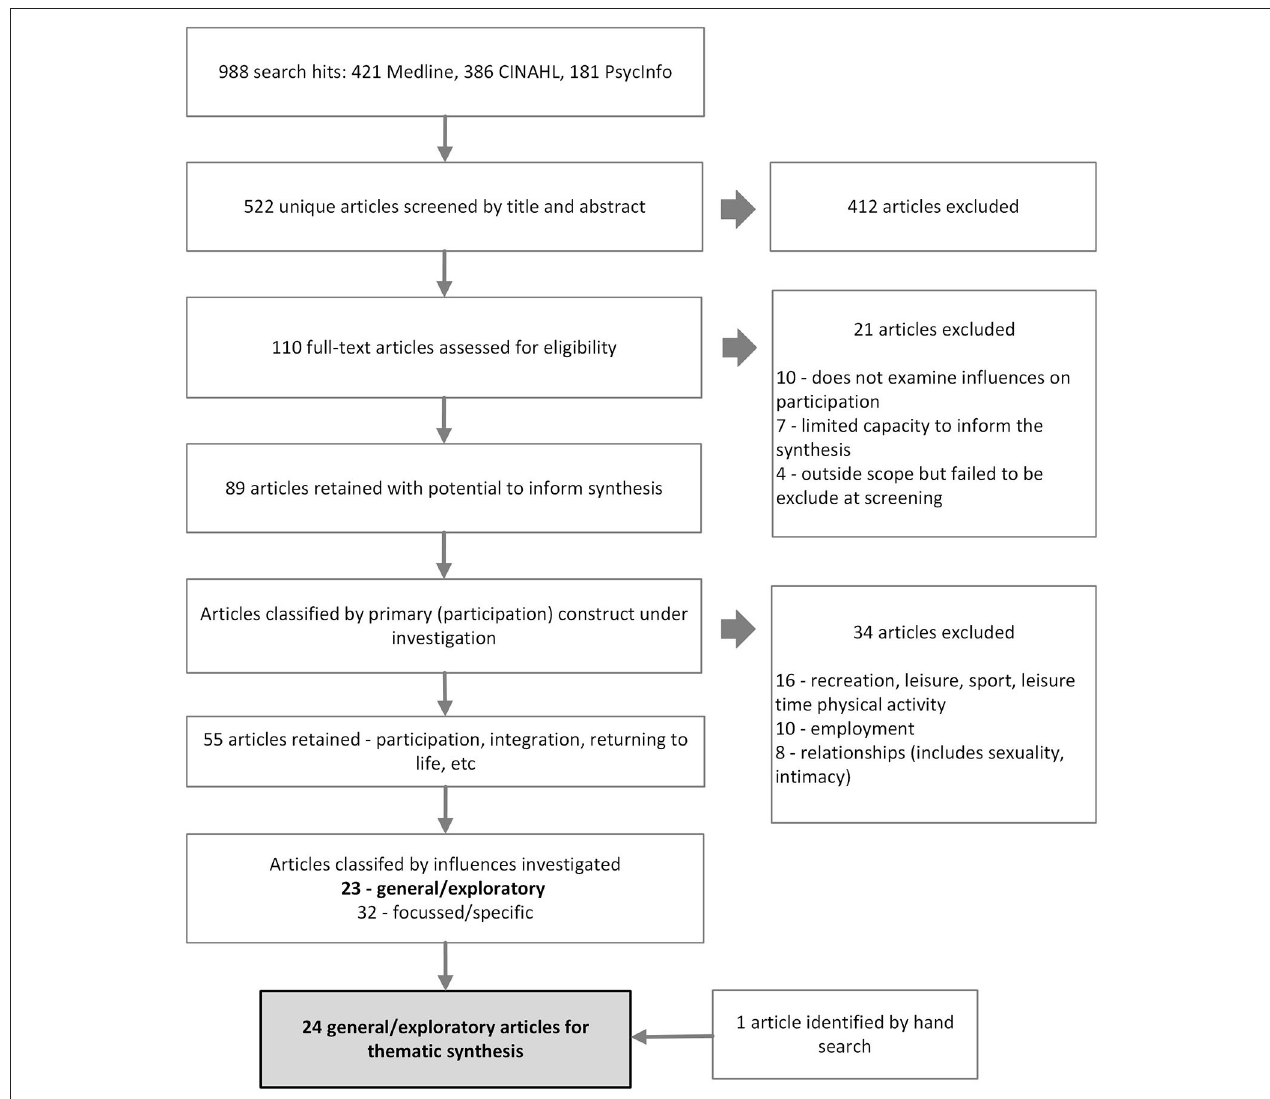
FIGURE 1 | Process of literature search and